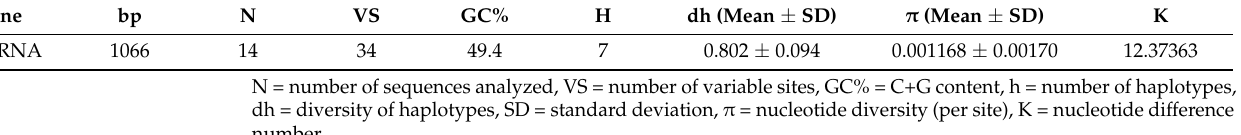
Table 3. Polymorphisms and diversity of 16Sr RNA sequences of Ehrlichia spp. obtained from coa- tis ( Nasua nasua ) sampled in the city of Campo Grande, Mato Grosso do Sul state, Brazil.